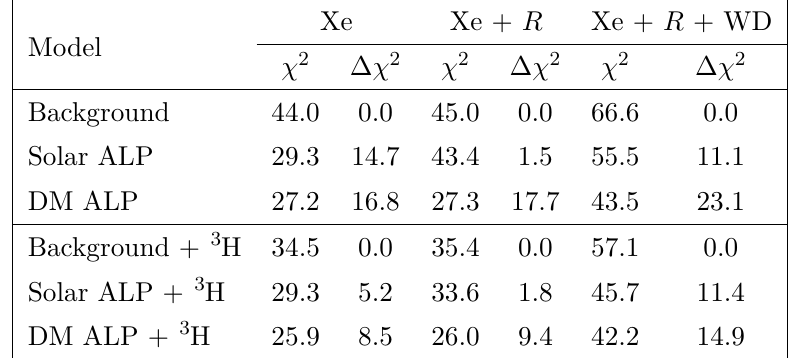
Table 2. The χ 2 values associated with the best-fit points in our models for the Xe data, when adding the R parameter, and finally when adding the WD hints. The ∆ χ 2 columns show the test statistic in eq. (4.1). For each model (solar or DM ALP) the test statistic is computed using the corresponding background (with or without 3 H ) as the null